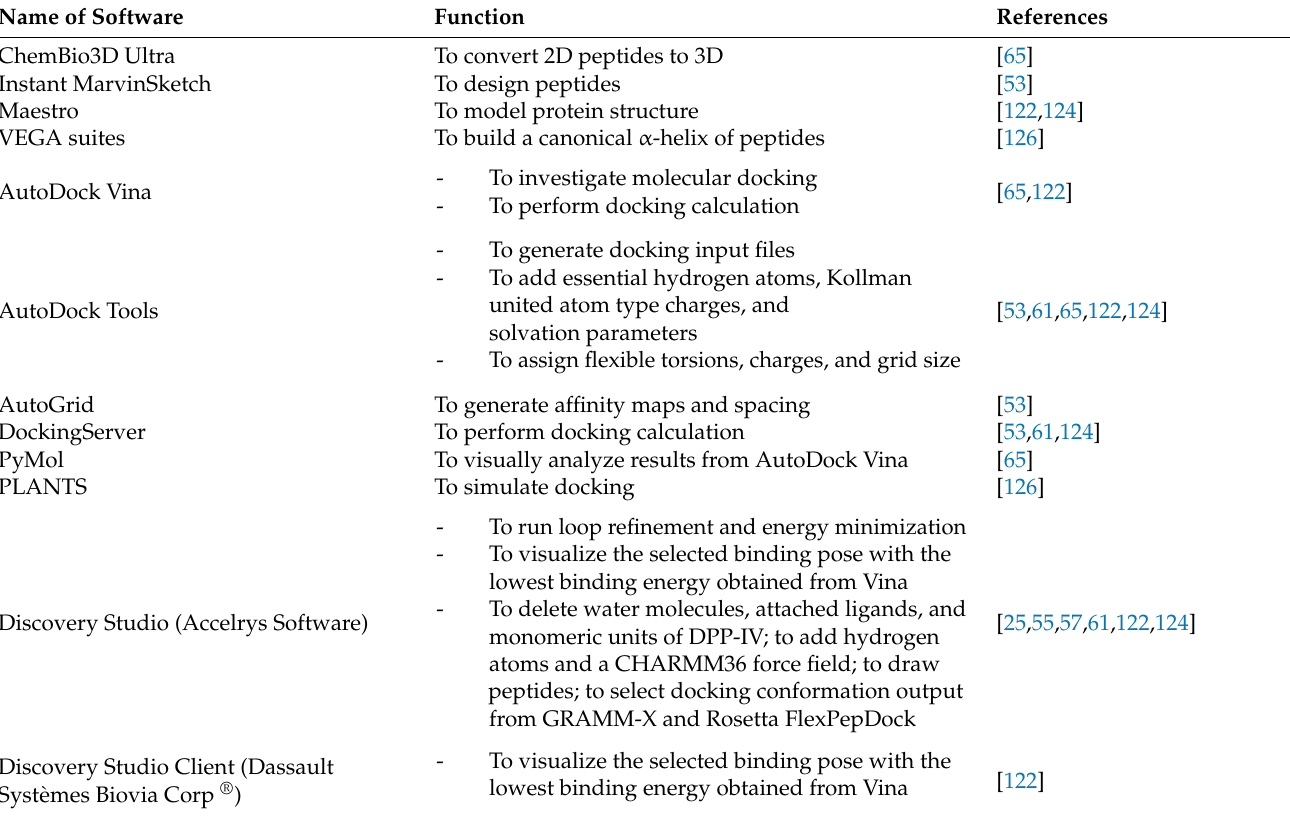
Table 8. Software tools used in leguminous antidiabetic peptides